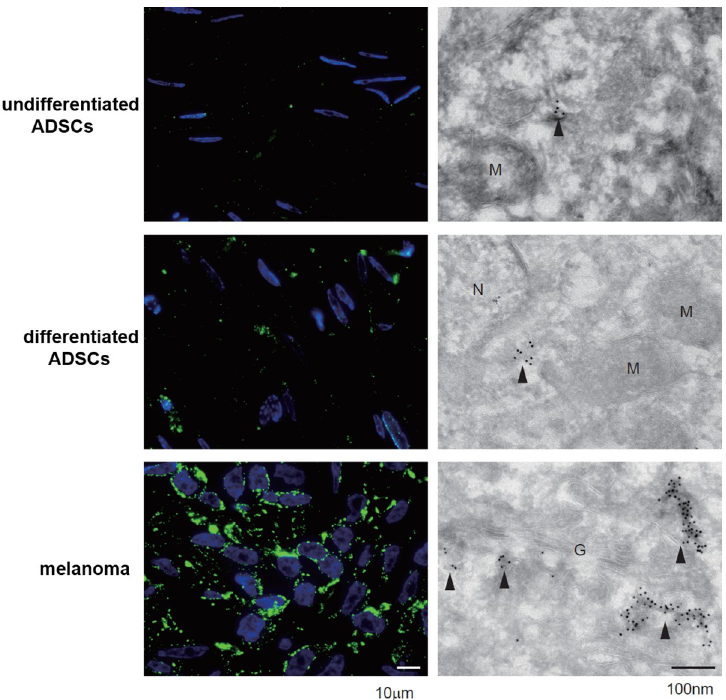
Fig 5. Immunofluorescence and immunoelectron microscopy with an anti-HMB45 antibody in undifferentiated ADSCs, differentiated ADSCs and melanoma cells. Note that the immunostaining intensity was increased in differentiated ADSCs. Immunogold particles mainly reacted with tubular structures due to the lack of mature melanosomes.